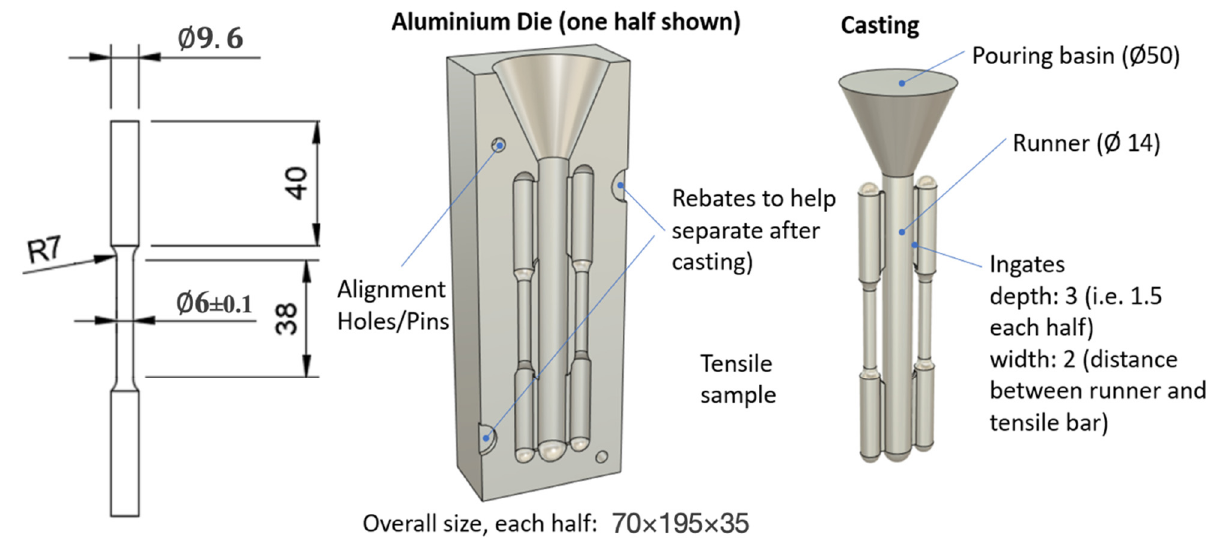
Figure 2. Schematic of the tensile bar and aluminum mold and resulting casting (all dimensions in